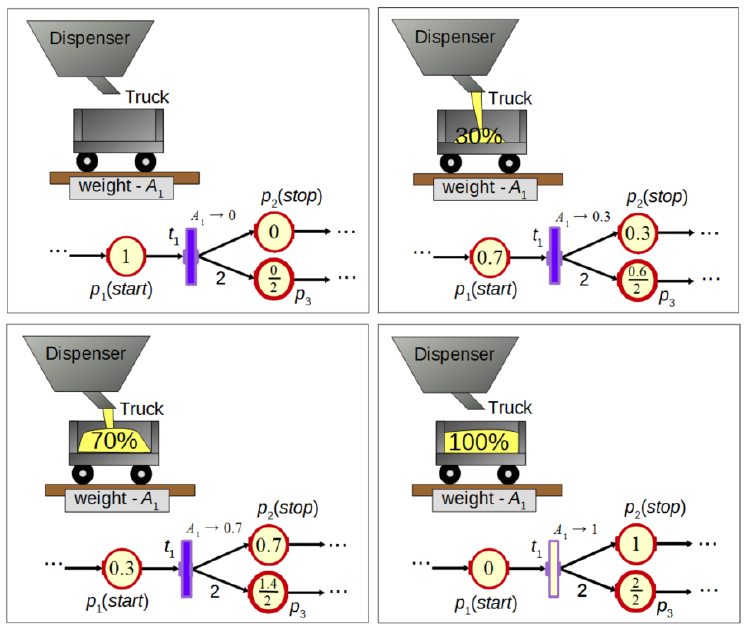
Figure 1. An algorithm in the form of a FIPN graph to control the dispensing